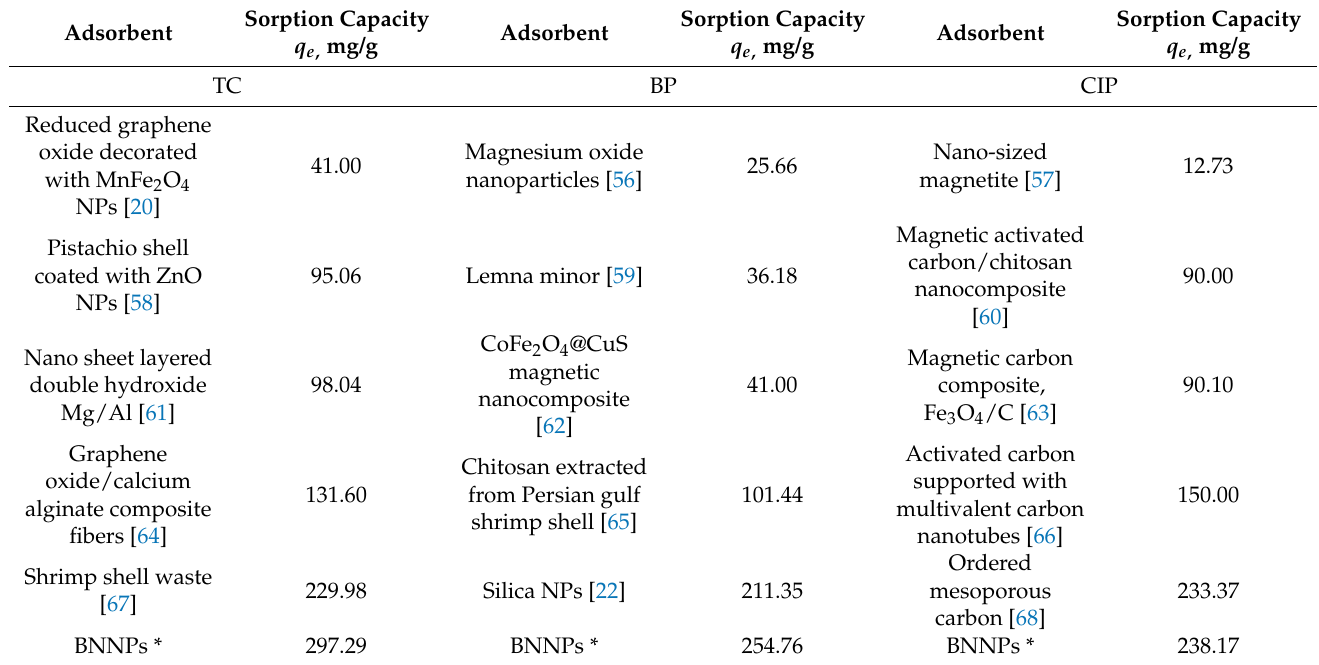
Table 3. Maximum adsorption capacity of benzylpenicillin (BP), tetracycline (TC), and ciprofloxacin (CIP) when using various